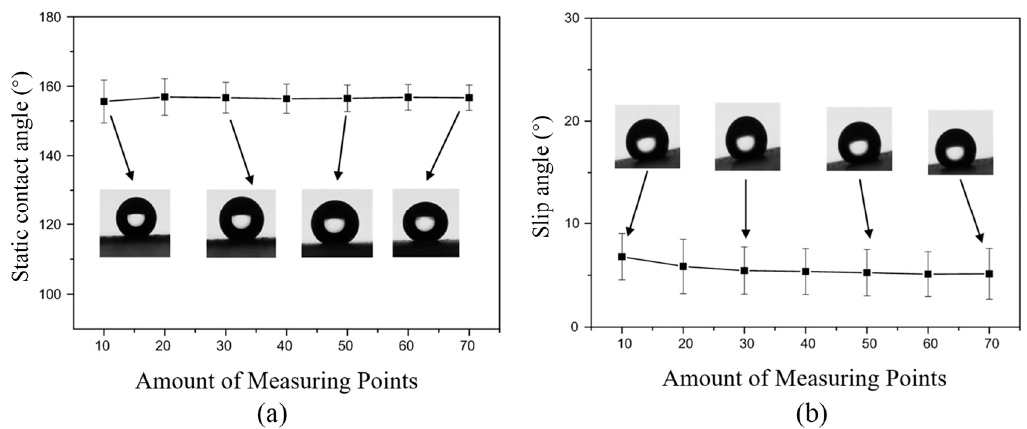
Figure 3. Water morphology on the fluorocarbon superhydrophobic coating ( a ) the static water contact angle of water droplets; ( b ) the slip angle of water droplets.